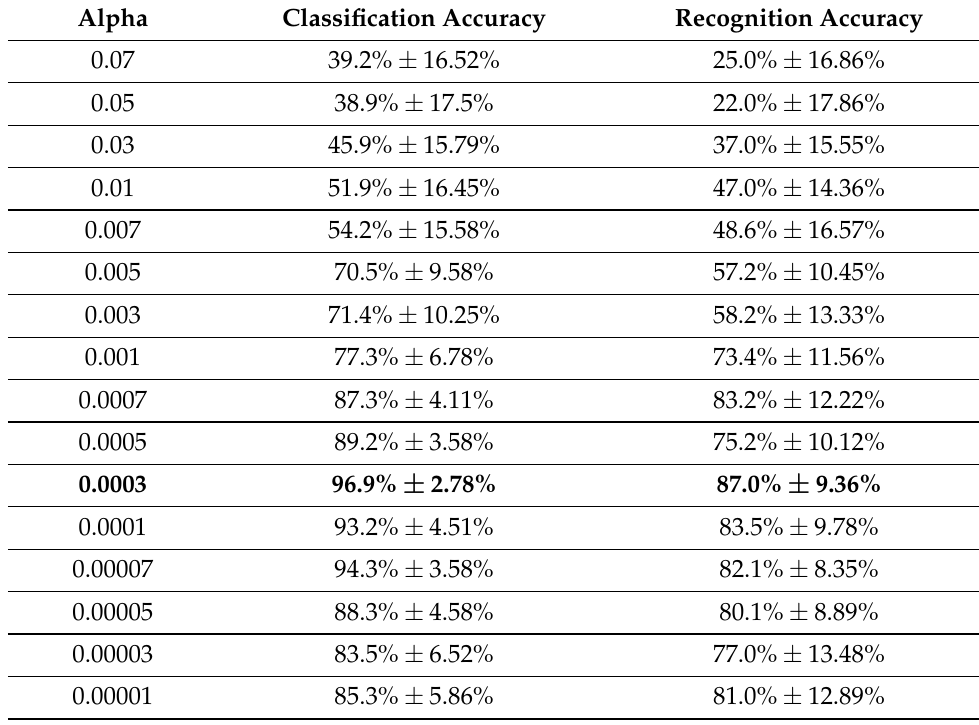
Table A1. User-specific validation results for Myo armband and G-force